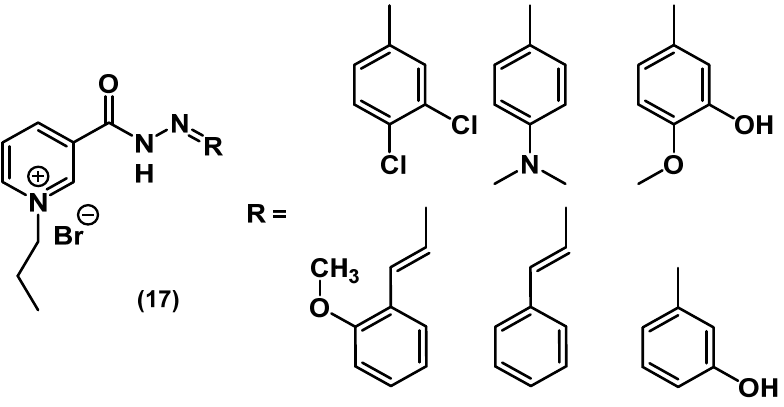
Figure 10. Mono-QACs containing hydrazide